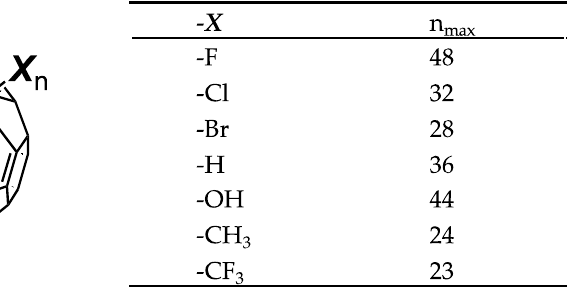
Figure 1. Reported multiply functionalized fullerenes C 60 X n (n > 20) [10–16].